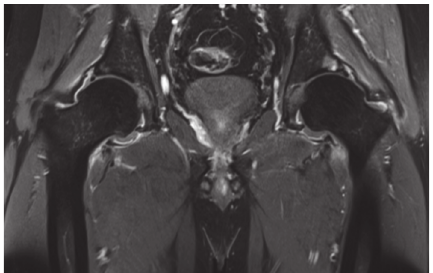
Figure 2: T2 weighted MRI demonstrating a hyperintense focus in the left superior acetabular rim and hip effusion and capsular edema consistent with osteomyelitis and septic